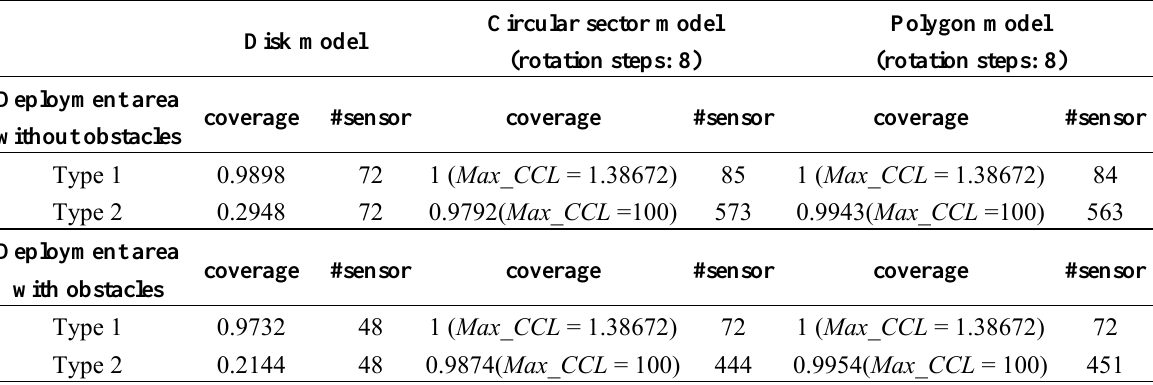
Table 5. The maximum sensing coverage rates and the usage of sensor nodes for each type in Case 2.